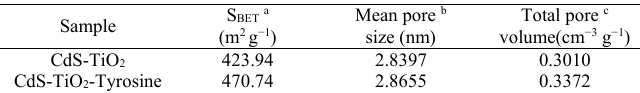
Table 1. Summary of the physicochemical properties of the samples.